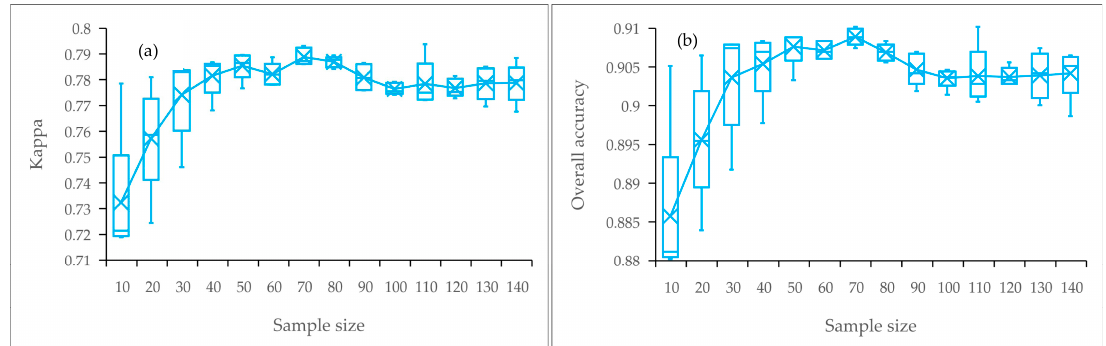
Figure 11. Performances of the time-series model using the number of training samples from 10 to 140. ( a ) Kappa, ( b ) Overall accuracy.